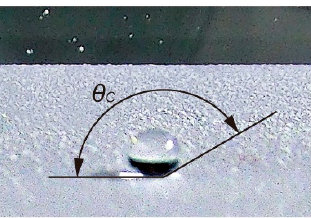
Figure 2. A photograph of a water droplet on the HIREC coating. The water contact angle, θ C , of the HIREC coating was 150 degrees.